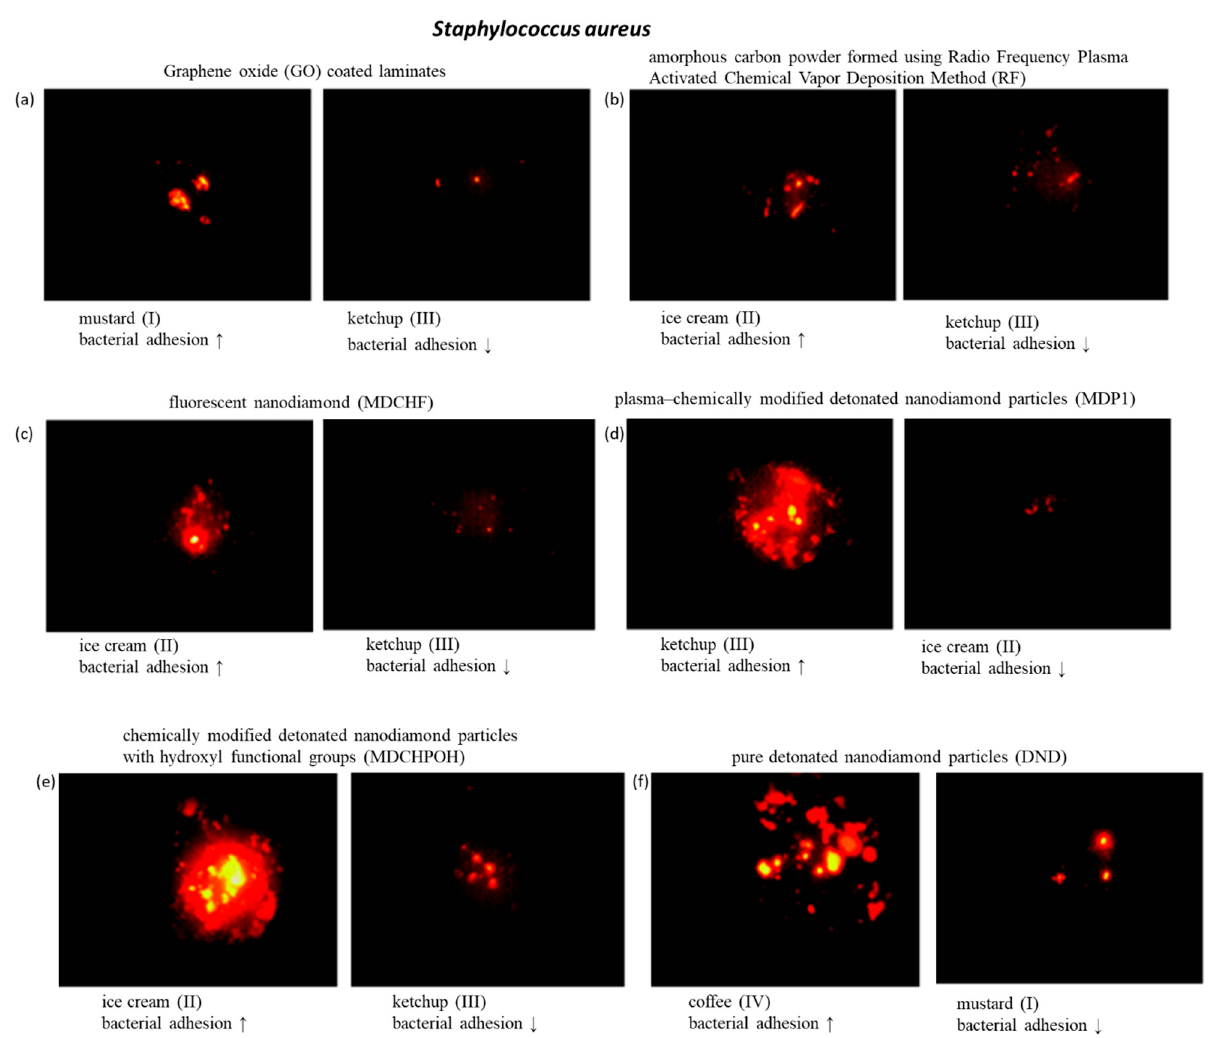
Figure 13. Images of Staphylococcus aureus adhesion to laminates for food films I—mustard, II—ice cream, III—ketchup, IV—coffee, with the lowest and highest adhesion to layers formed by: ( a ) Graphene Oxide (GO) film; ( b ) amorphous carbon powder formed using Radio Frequency Plasma Activated Chemical Vapor Deposition Method (RF); ( c ) fluorescent nanodiamond (MDCHF); ( d ) plasma–chemically modified detonated nanodiamond particles (MDP1); ( e ) chemically modified detonated nanodiamond particles with hydroxyl functional groups (MDCHPOH); ( f ) pure detonated nanodiamond particles (DND).